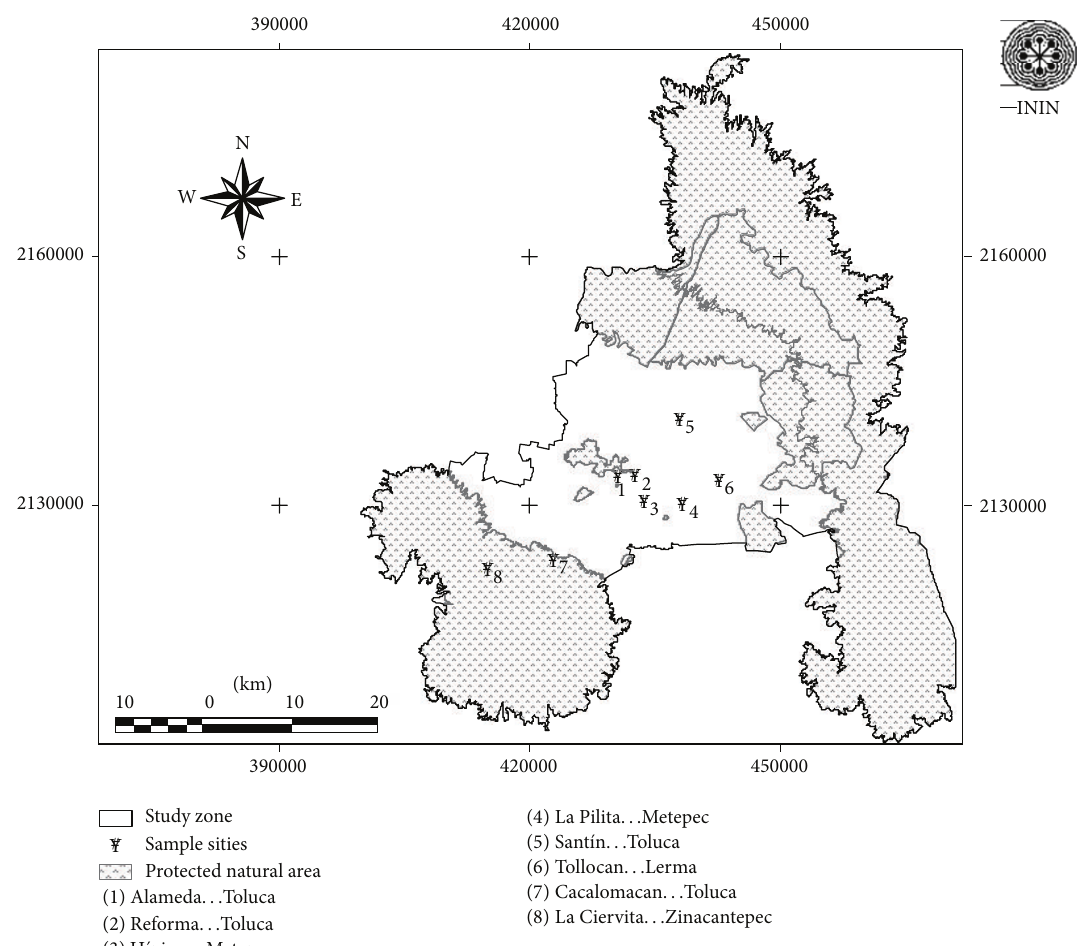
Figure 1: Geographical distribution of sampling locations at the Metropolitan Zone of the Valley of Toluca.